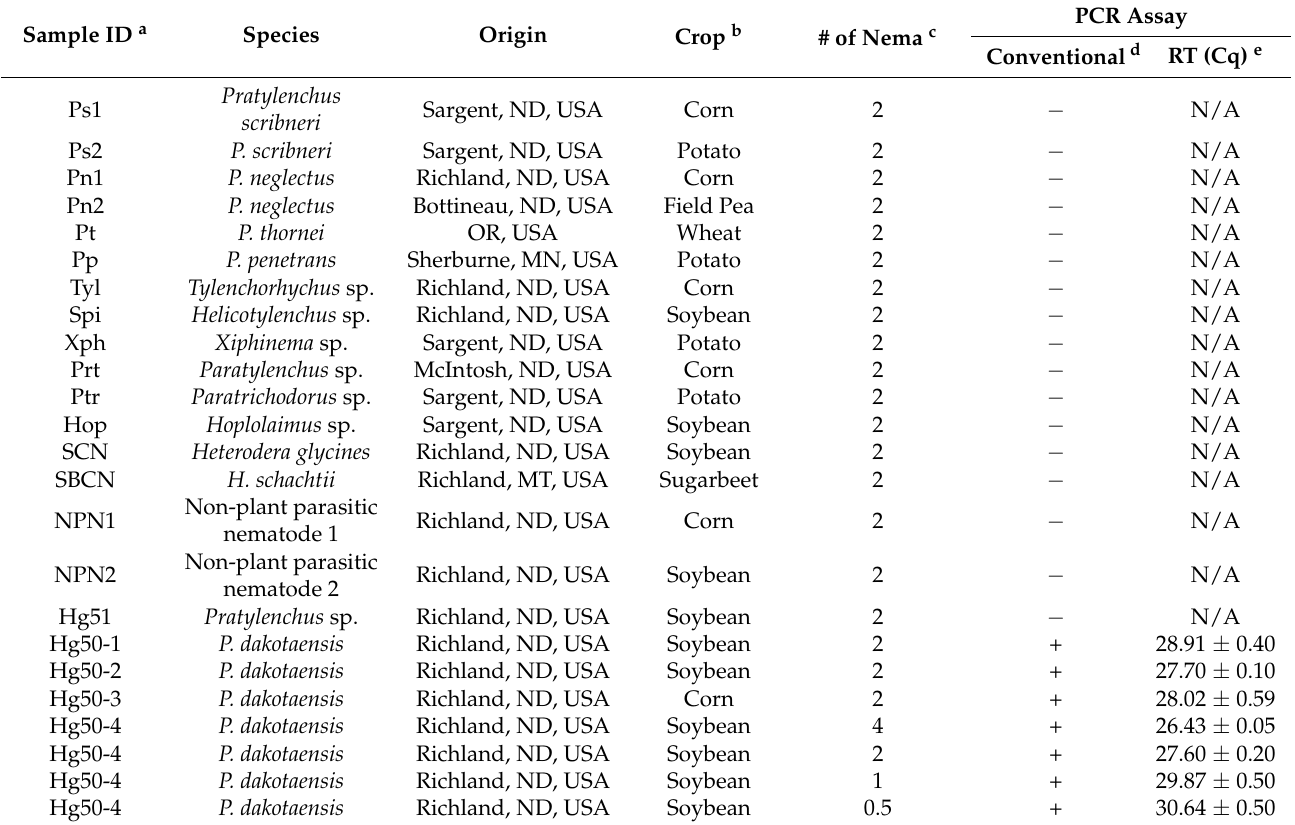
primers rDNA2/rDNA1.58s, confirming the presence of template DNA in each of the samples tested. As expected, real-time PCR amplifications with the non-target control species yielded no fluorescence signal, thus Cq values were not detectable. However, Cq values ranging from 26.43 ± 0.05 to 30.64 ± 0.50 were recorded from real-time PCR with the various populations of P. dakotaensis at varying numbers of P. dakotaensis individuals in DNA extracts (Table 2). Melting curve analysis revealed a single melting peak at 81.5 ◦ C and no secondary curves confirming a single amplicon specific for each of the four populations of P. dakotaensis (Figure 1). For both conventional and real-time PCR assays, no amplicons were generated in non-template controls containing water instead of DNA. Table 2. Taxon, geographic origin, current crop, and polymerase chain reaction (PCR) assays of the control nematode species used to test the specificity of IC-ITSF/ITS1R primer set designed to identify and detect P. dakotaensis